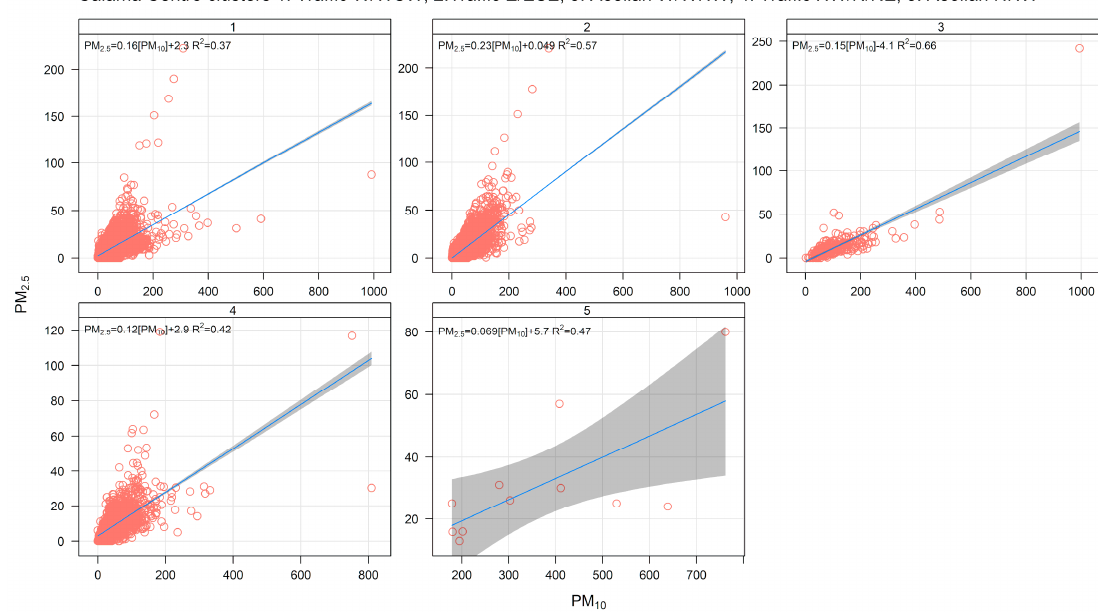
Figure 6. PM 2.5 - PM 10 scatter plot by cluster for a five-cluster solution for Calama. Figure 6. PM 2.5 –PM 10 scatter plot by cluster for a five-cluster solution for